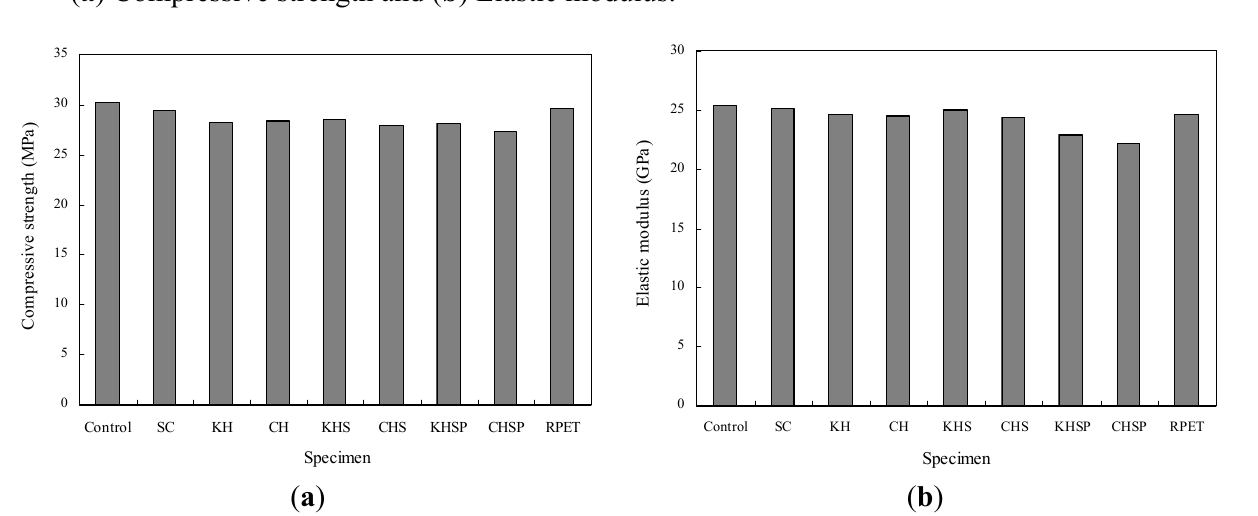
Figure 8. Compressive strength and elastic modulus of Hwangtoh concrete from main tests ( a ) Compressive strength and ( b ) Elastic